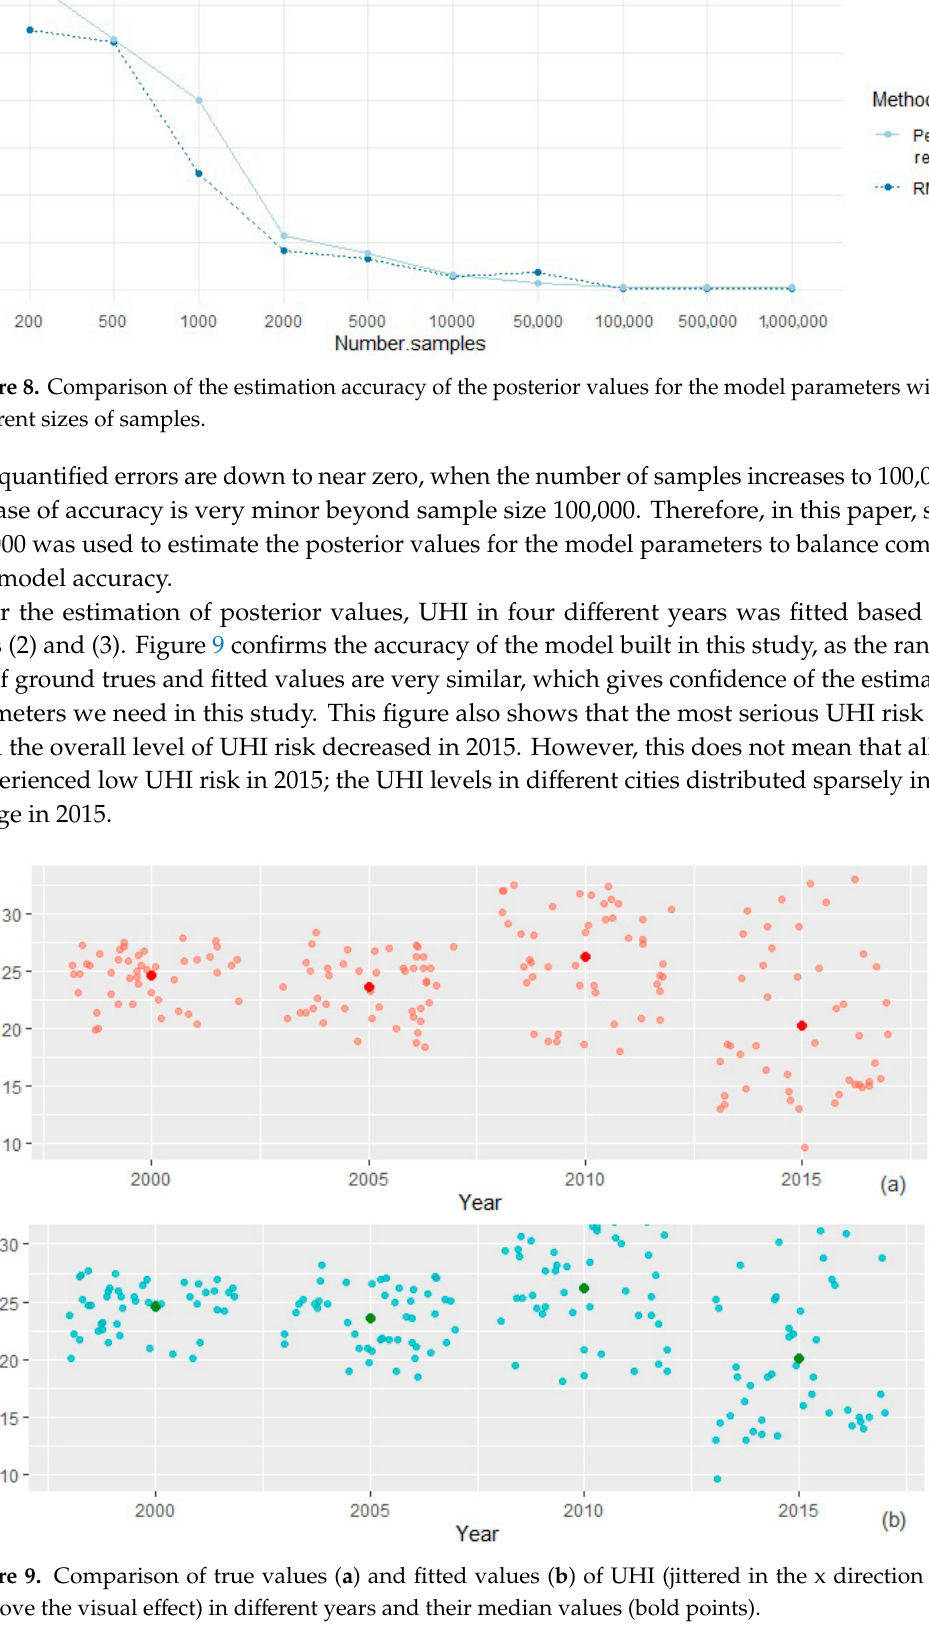
Figure 9. Comparison of true values ( a ) and fitted values ( b ) of UHI (jittered in the x direction to improve the visual e ff ect) in di ff erent years and their median values (bold